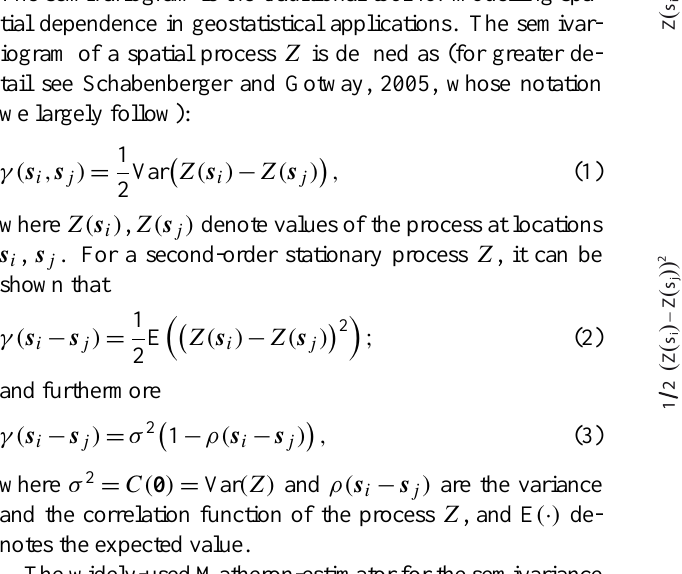
theor. correlation correl. from semivariogram model nonparam. correlation bias−correct. nonparam. correlation